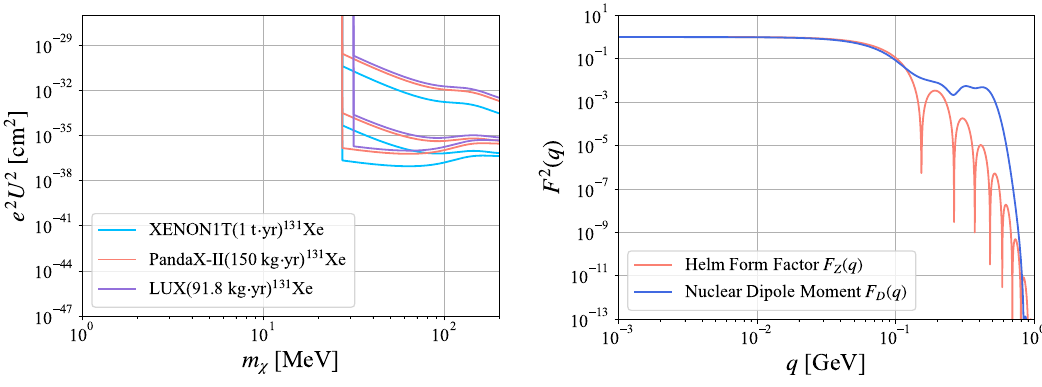
Figure 5 . Left: the projected constraint on e 2 U 2 from dipole-dipole contribution for 131 Xe target. The assumed dark photon masses are the same as those in figure 4. Right: the comparison of form factors F 2 ( q ) and F 2 ( q ) Z D